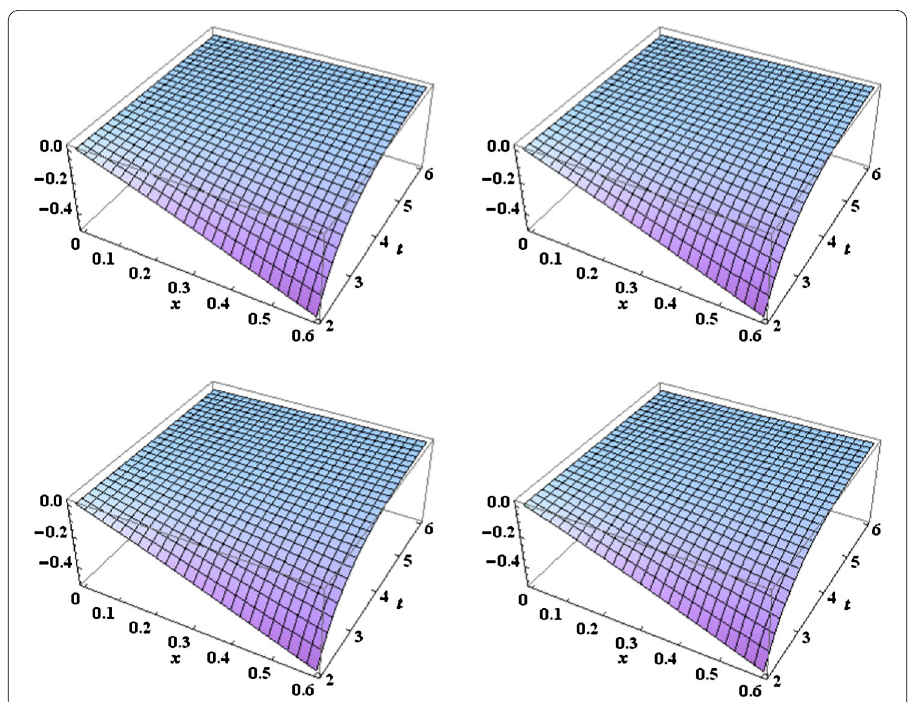
Figure 3 The approximate solutions for Example 4.2 when β = 0.25, β = 0.5, β = 0.75 and β = 0.90, respectively.